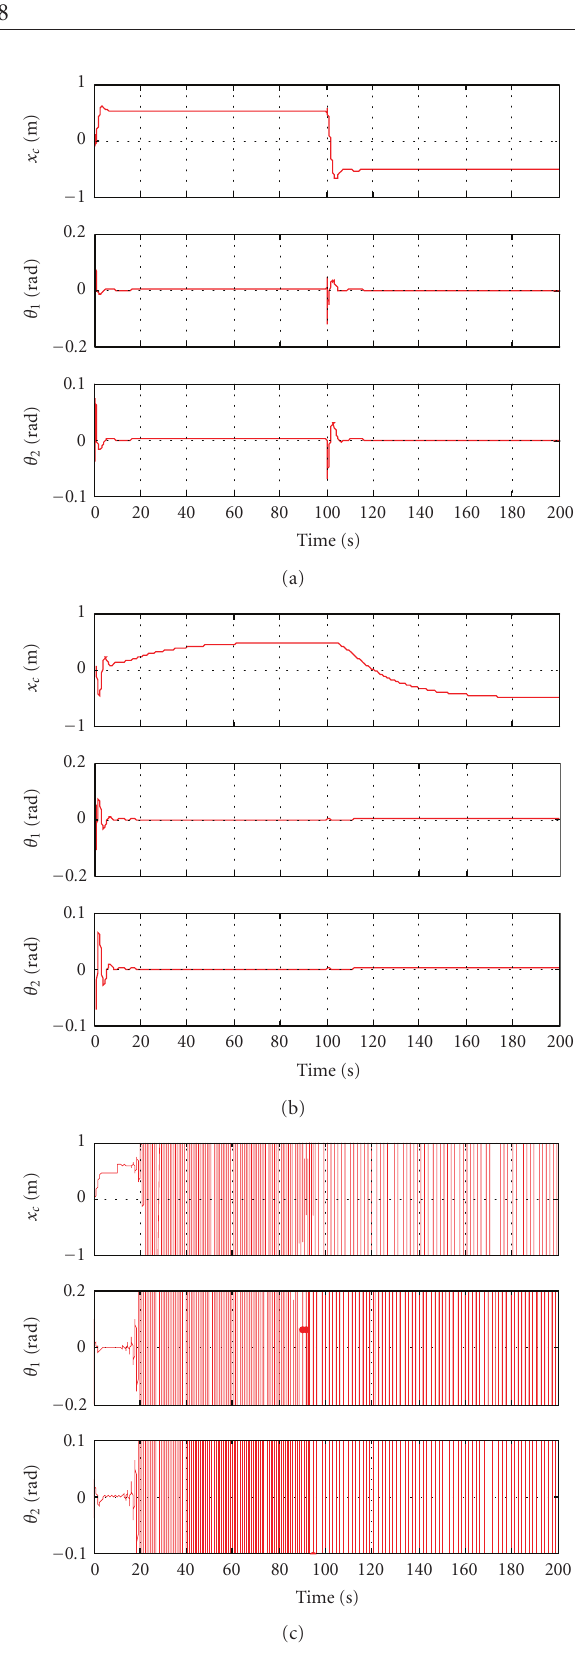
Figure 11: System responses of all controllers under θ 2 sensor fault at 10% deterioration, without uncertainties. (a) —- FTCS, (b) ... H ∞ controller, and (c) - - - μ controller. mum error of 0.04